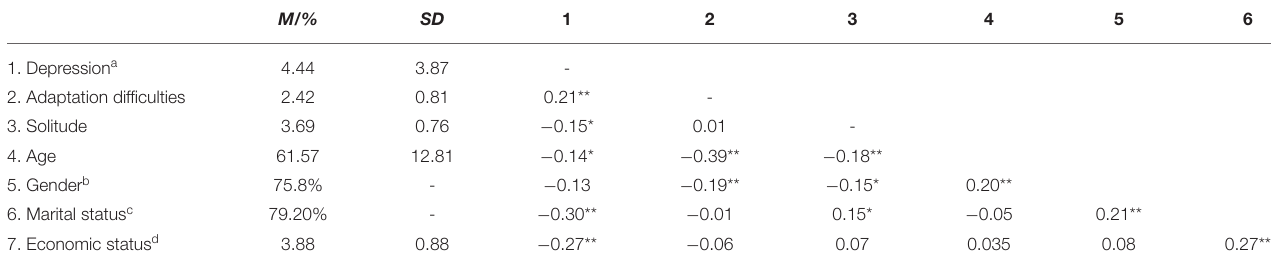
TABLE 2 | Demographics and correlations for the study